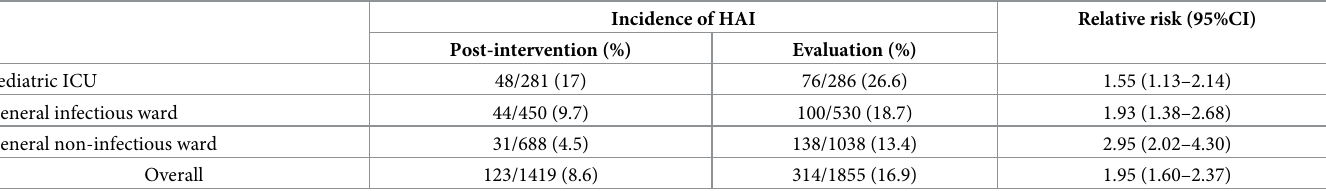
Table 3. The incidence of healthcare-associated infection over the study